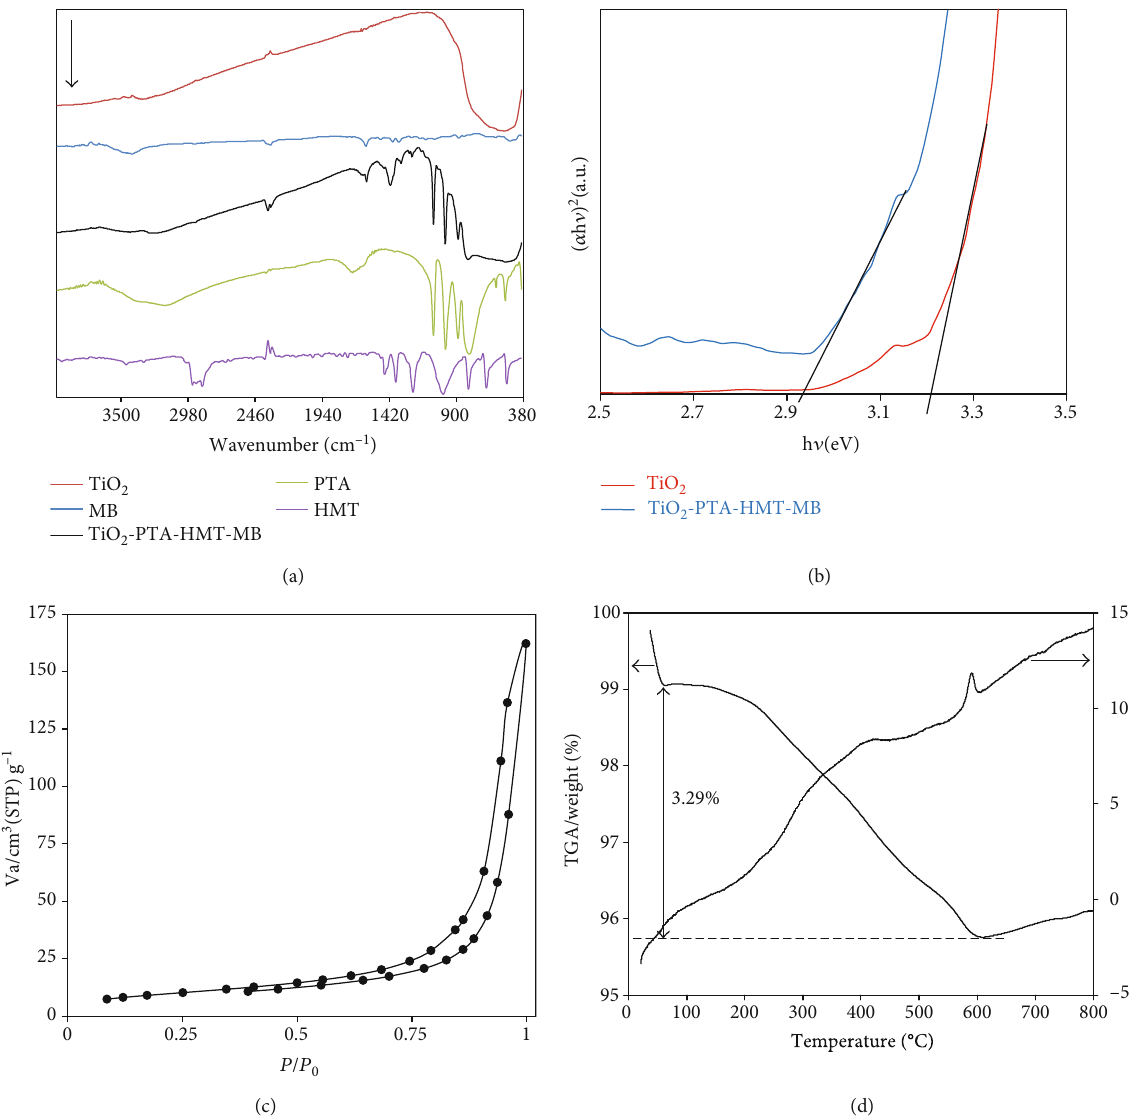
Figure 1: (a) FTIR spectra, (b) Tauc ’ s plots of TiO with photon energy (h ν ), (c) N